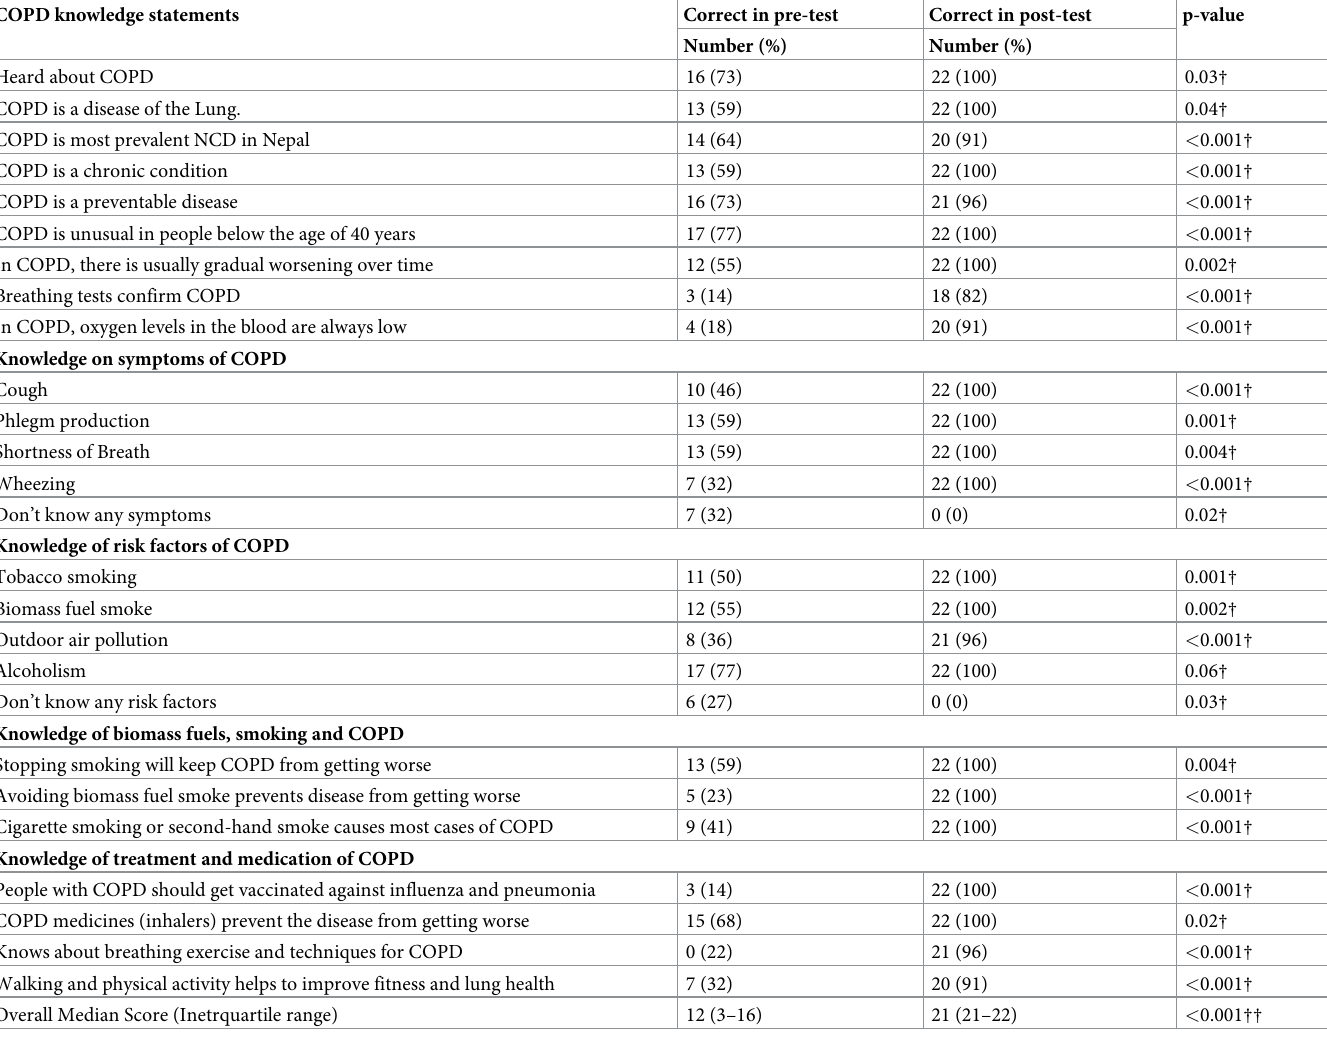
Table 1. Results of Female Community Health Volunteers’ COPD-related knowledge before and after training (n =